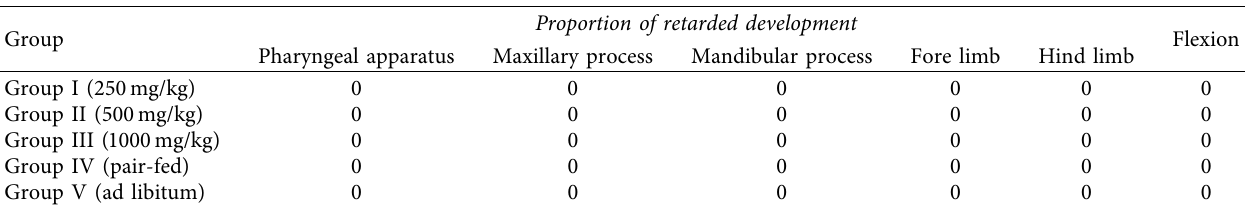
Table 4: Embryonic developmental indices of the musculoskeletal system after treatment with the 80% ethanol fruit extract of Embelia schimperi .